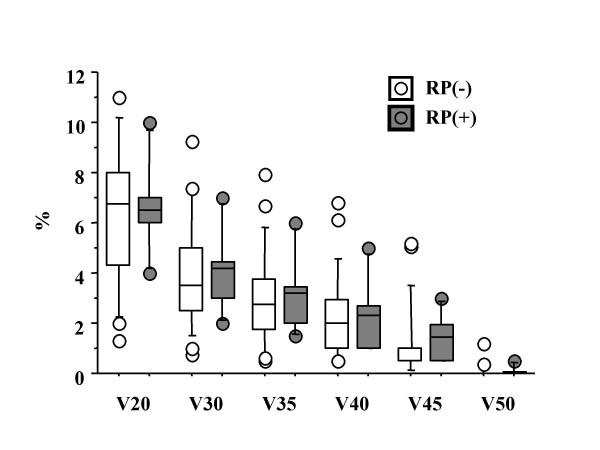
The correlation comparing the occurrence of RP grade 2 or more with V20-V50.